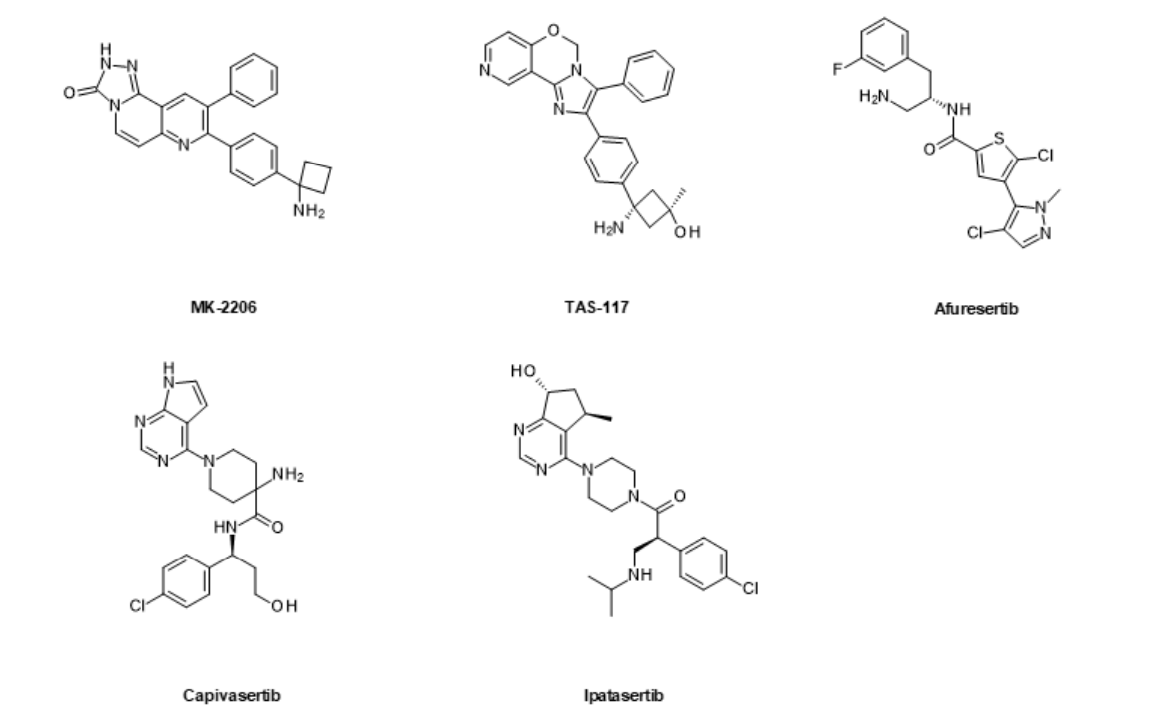
Figure 7. Inhibitors of AKT in advanced clinical trials.